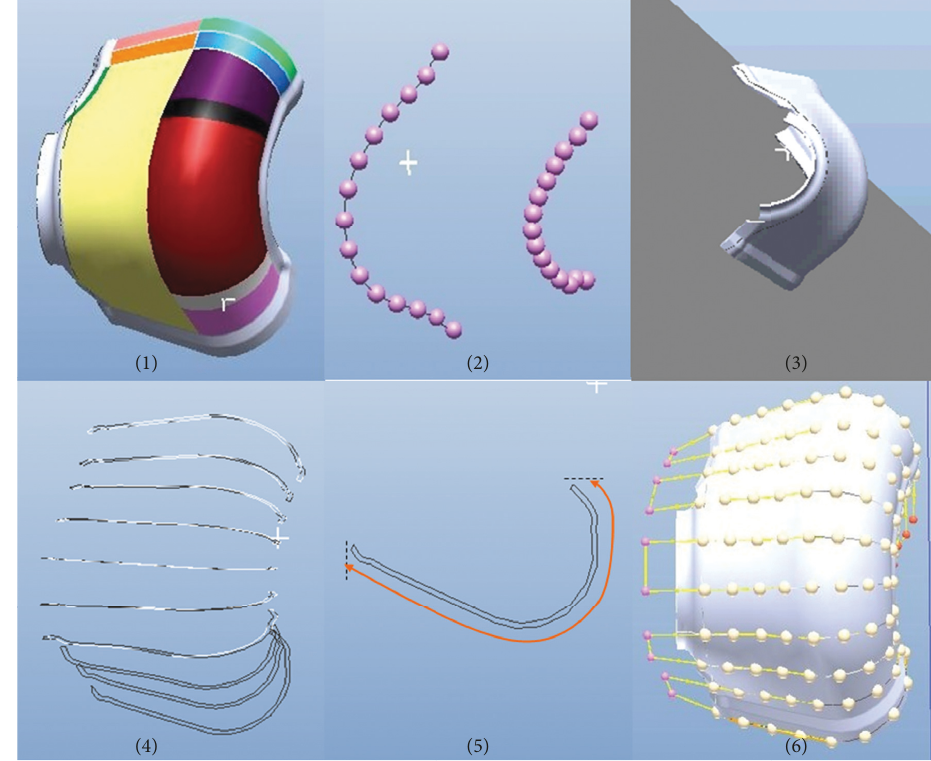
Figure 9: Autogeneration for complex curved surface.